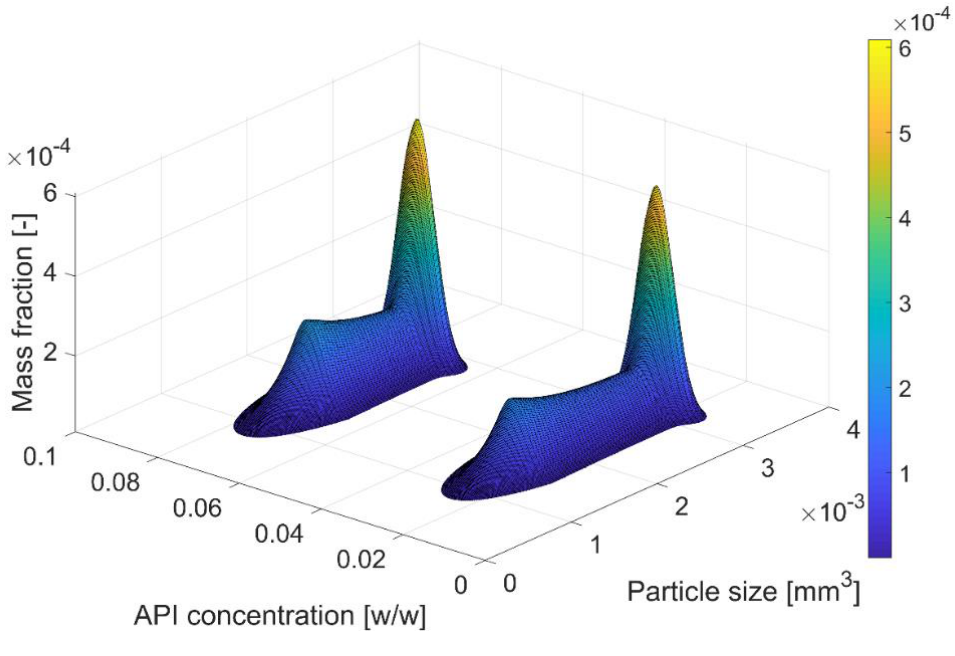
Processes 2019 , 7 , x FOR PEER REVIEW Figure 10. Simulation results of the breakage process. Figure 10. Simulation results of the breakage process.